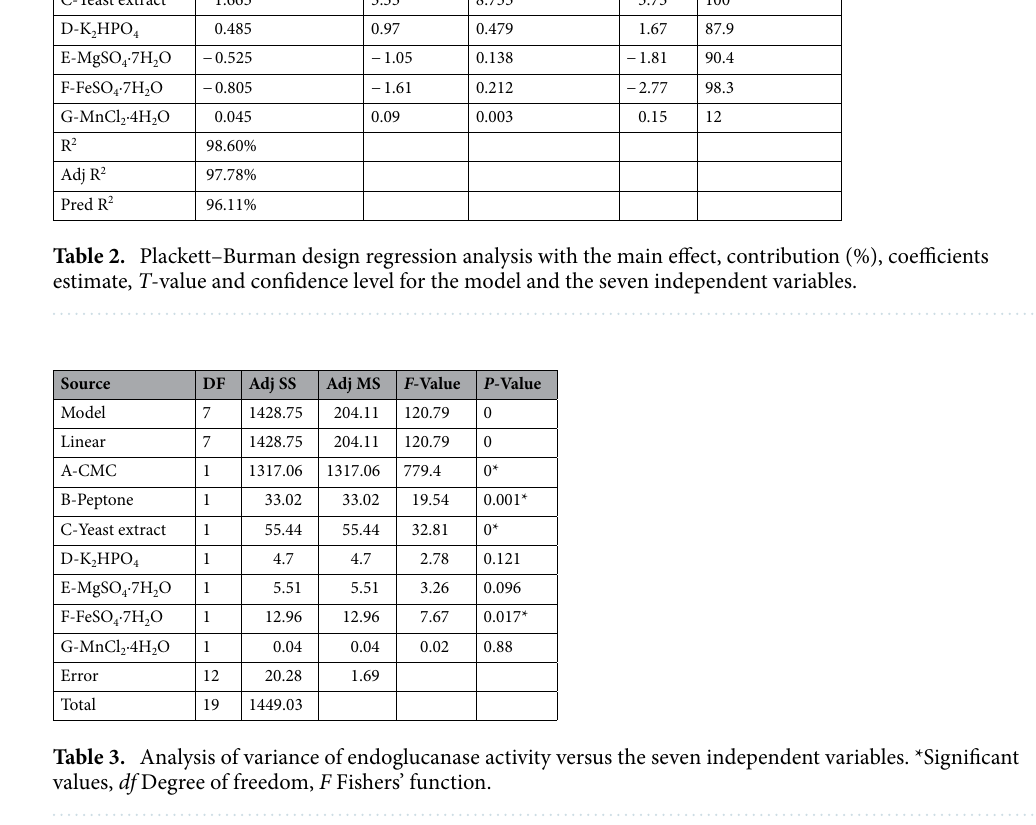
Pareto chart Fig. 5B revealed that CMC (A) was the best factor affecting endoglucanase production and hence activity (27.92) followed by Yeast extract (C), peptone (B), FeSO 4 ·7H 2 O (F), MgSO 4 .7H 2 O (E), K 2 HPO 4 (D), adequacy of the model 74 . By plotting the residuals against the theoretical values predicted by the model, the line. This indicates that the model successfully suited the experimental results.